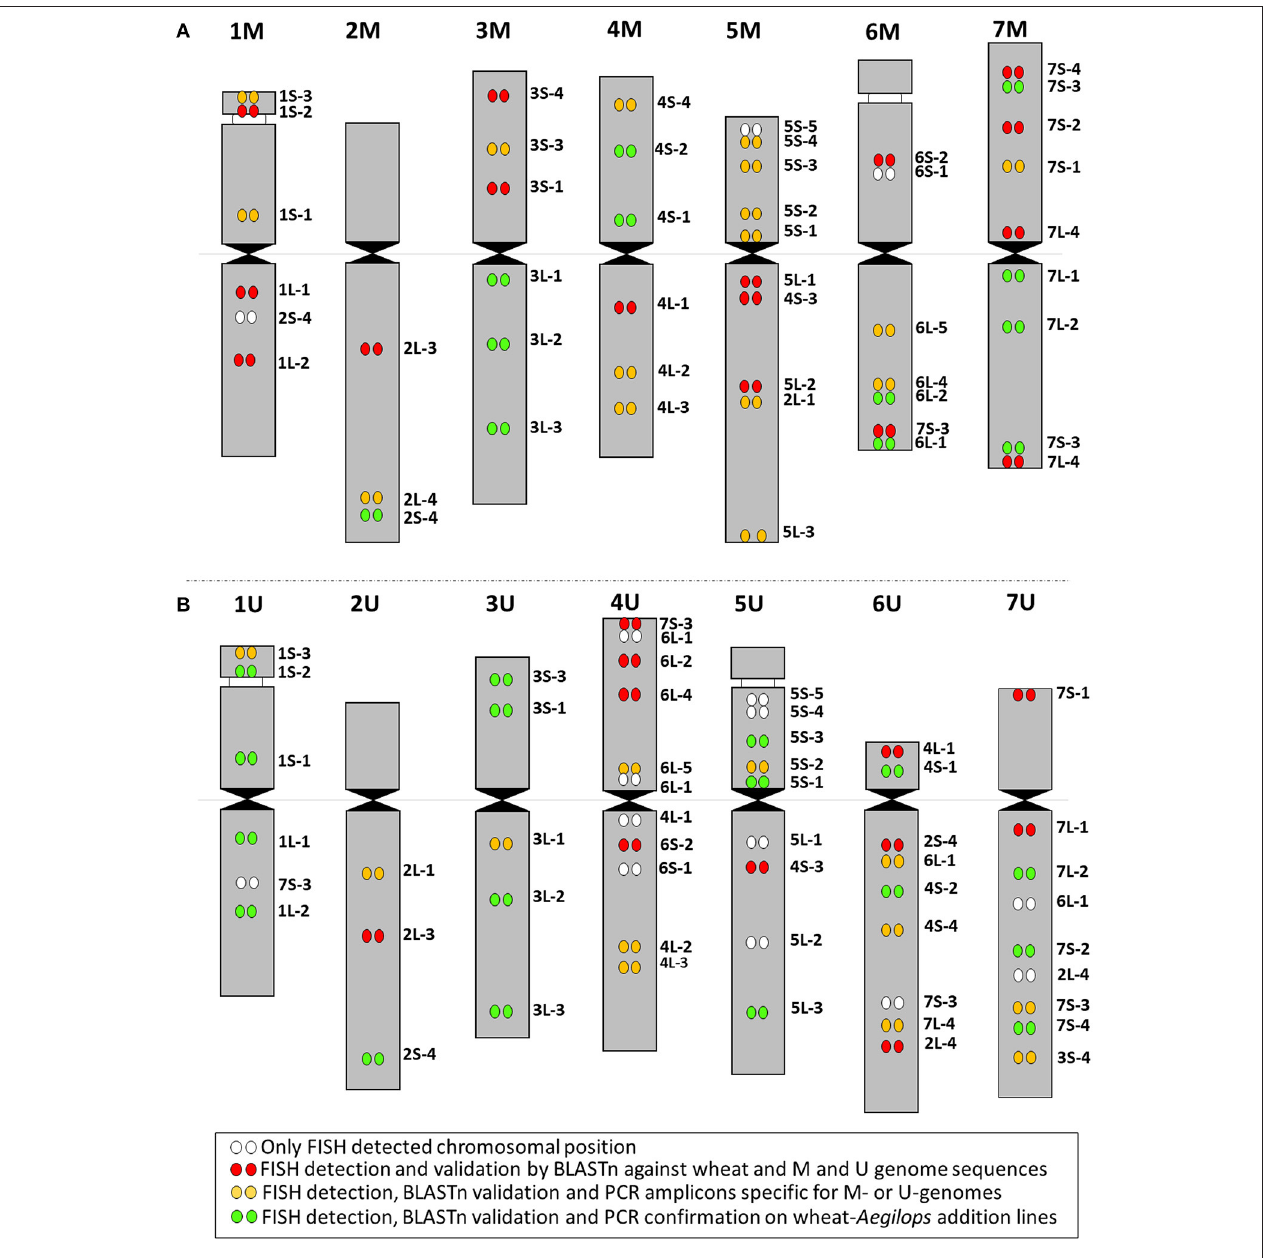
FIGURE 6 | Idiogram summarizing the results of FISH mapping of cDNAs on (A) M- and (B) U-genome chromosomes. The color scheme (bottom) indicates detection of the cDNAs as FISH probes on M and U genomes (white dots), detection as FISH probes and in silico validation by BLASTn against bread wheat and M- and U-genome sequences (red dots); detection as FISH probes, validation by BLASTn and PCR amplicons specific for M or U genomes (yellow dots); detection as FISH probes, validation by BLASTn, and PCR markers validated on wheat- Aegilops addition lines (green dots).